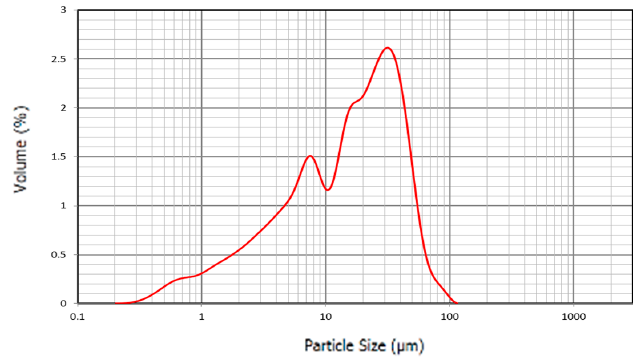
Figure 10. Particle size distribution C.